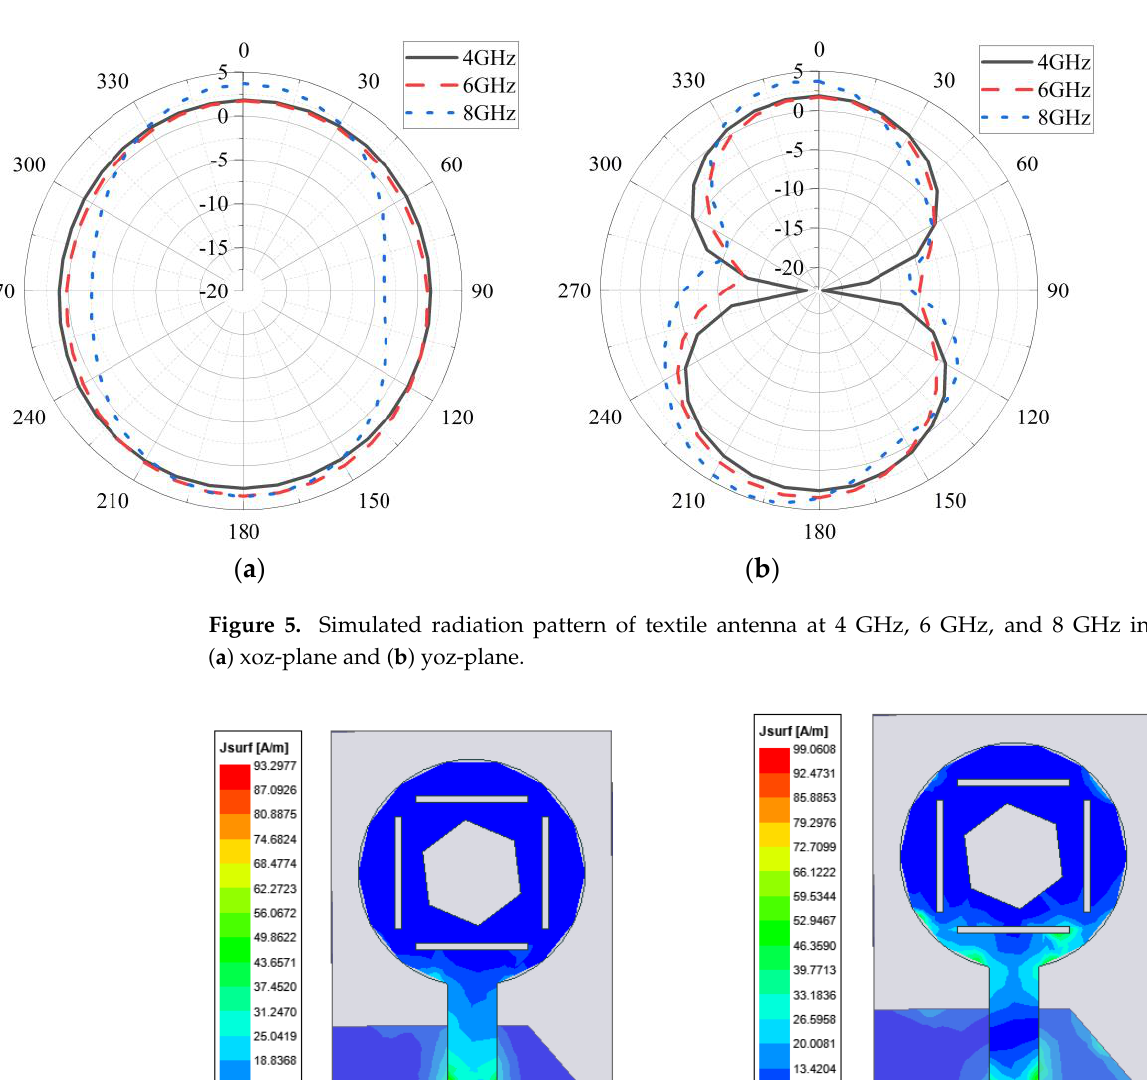
Figure 6. The current distribution of the UWB antenna with a phase of 0° at ( a ) 3.5 G and ( b ) 8.2 G.